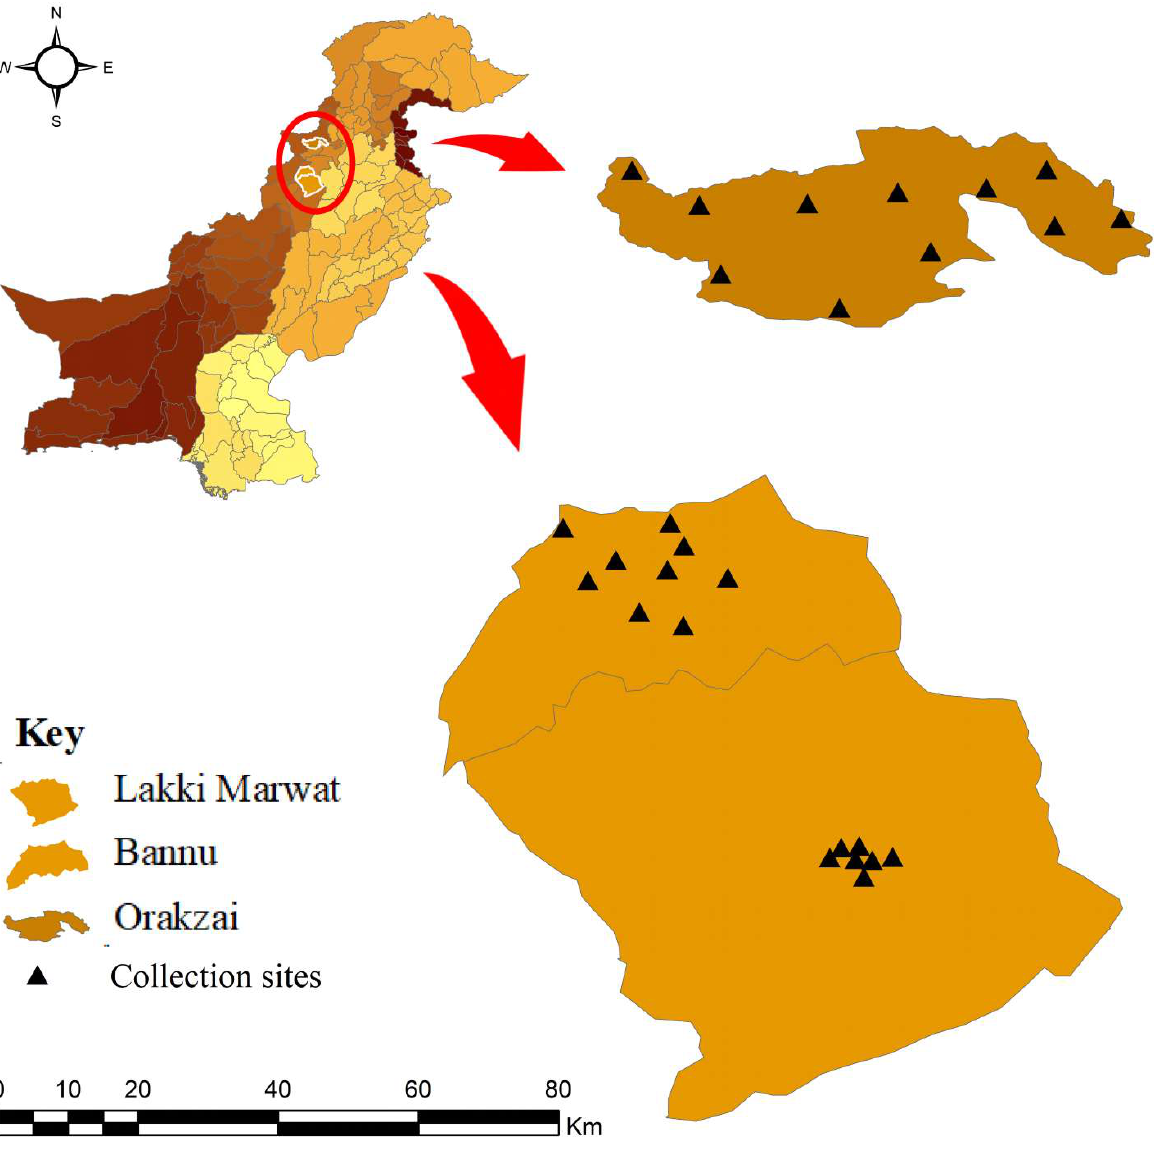
Figure 1. Map showing tick collection sites in southern Khyber Pakhtunkhwa, Pakistan.